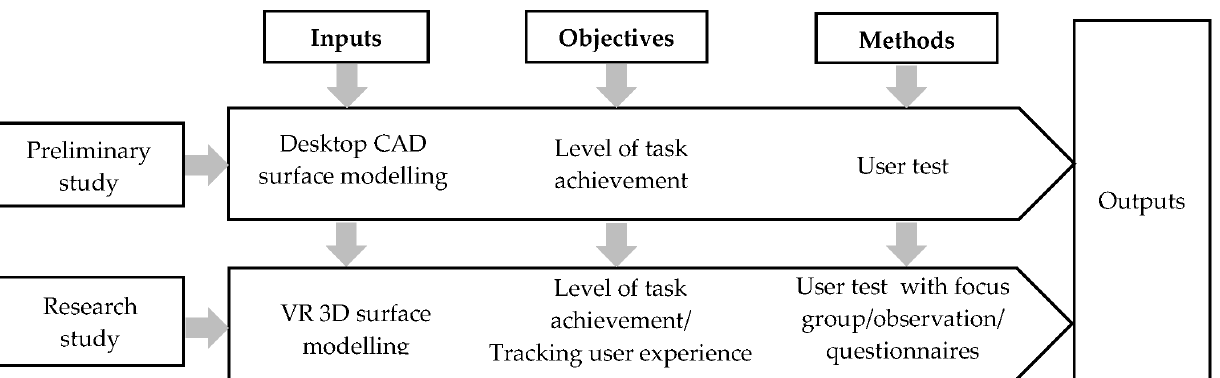
Figure 1. The methodological framework.